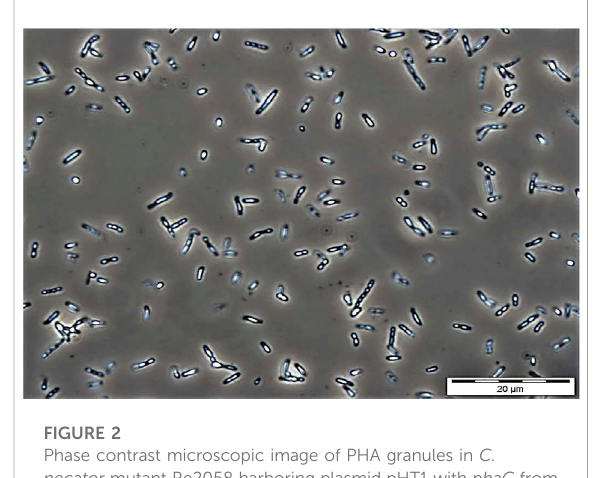
FIGURE 2 Phase contrast microscopic image of PHA granules in